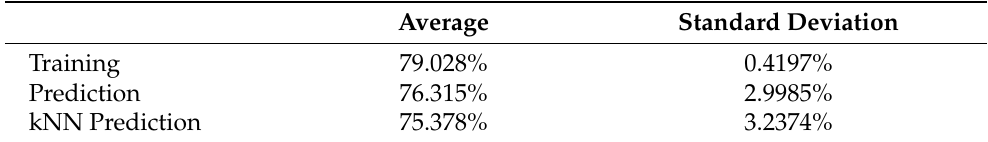
Table 6. TESSOM training accuracy